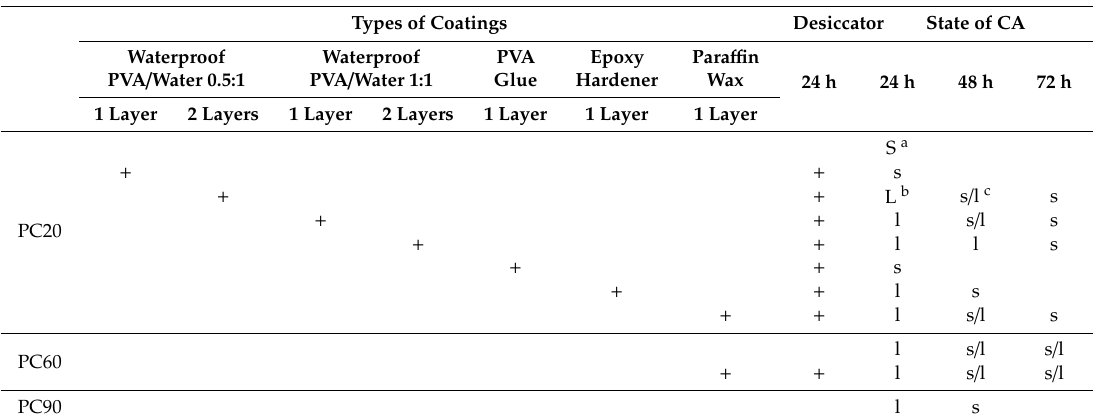
Table A4. Longevity test of cyanoacrylate adhesives in clear PLA macro-capsules. Types of